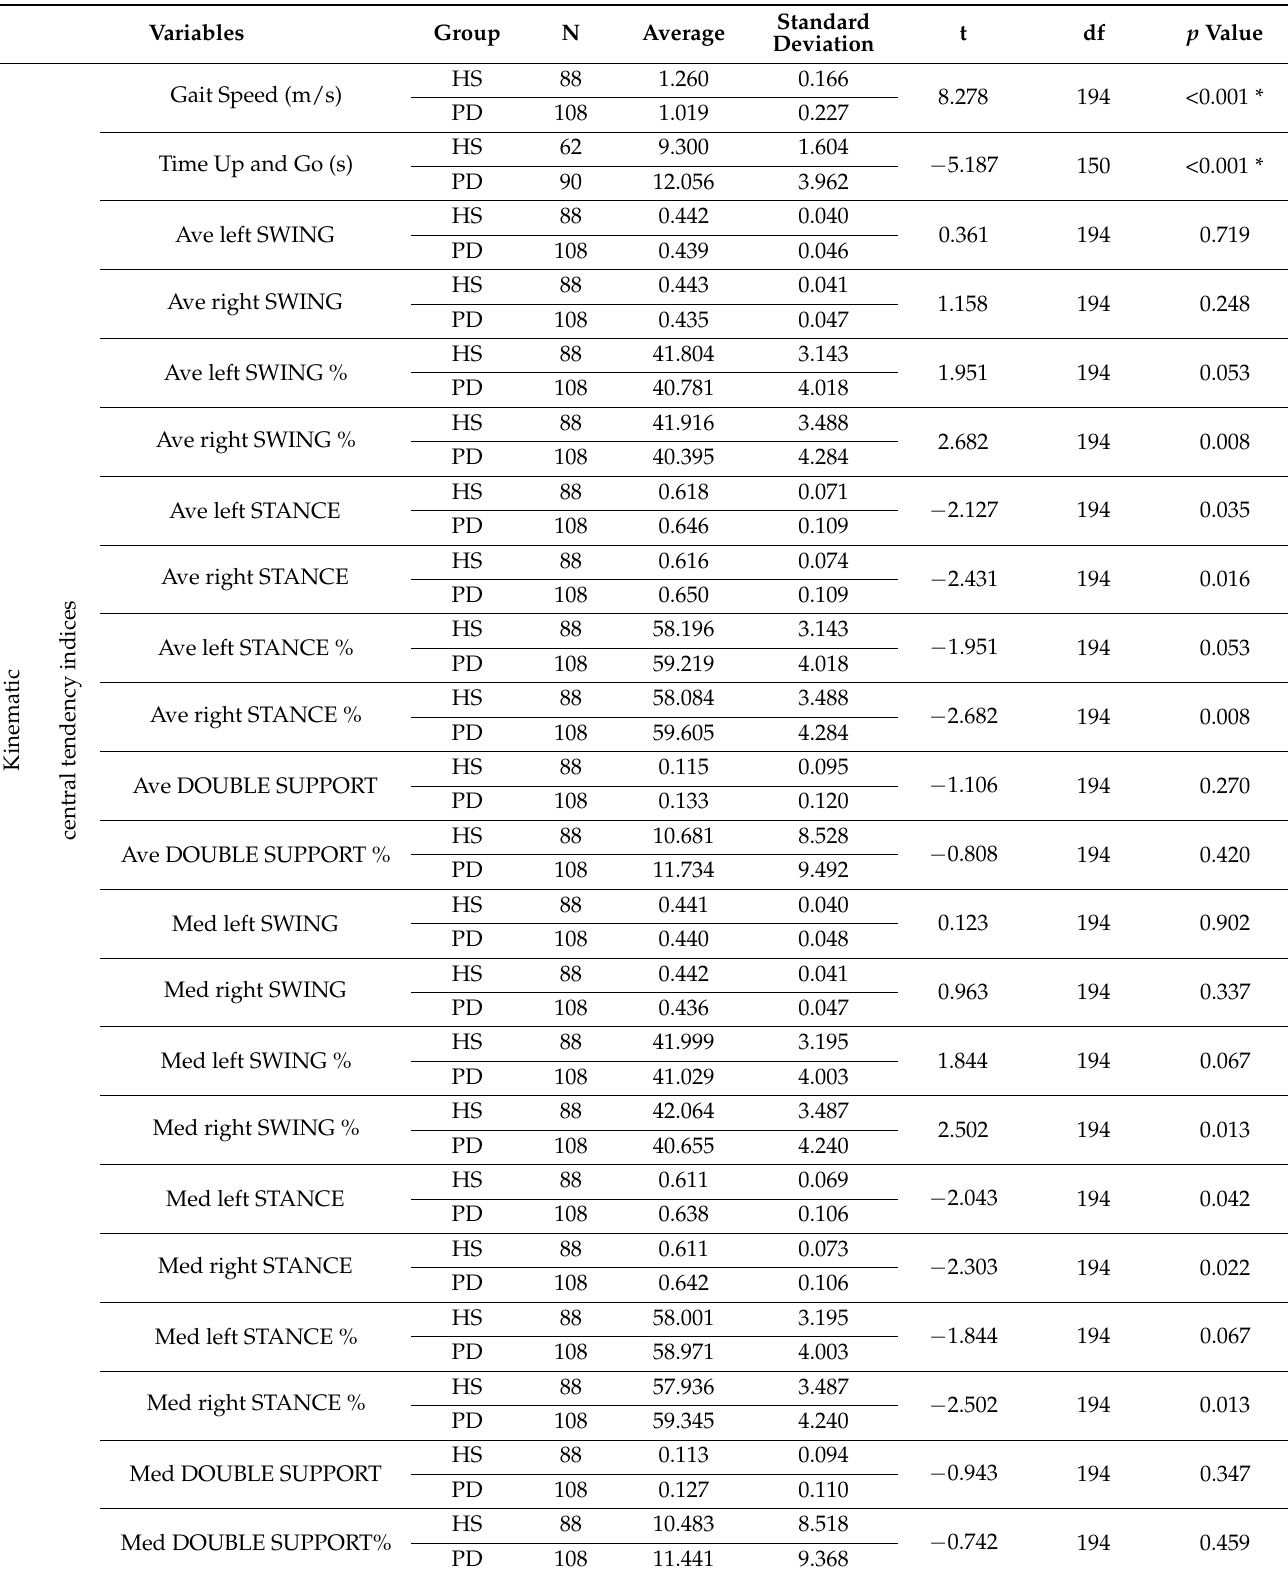
Table 3. Kinematic central tendency and dispersion